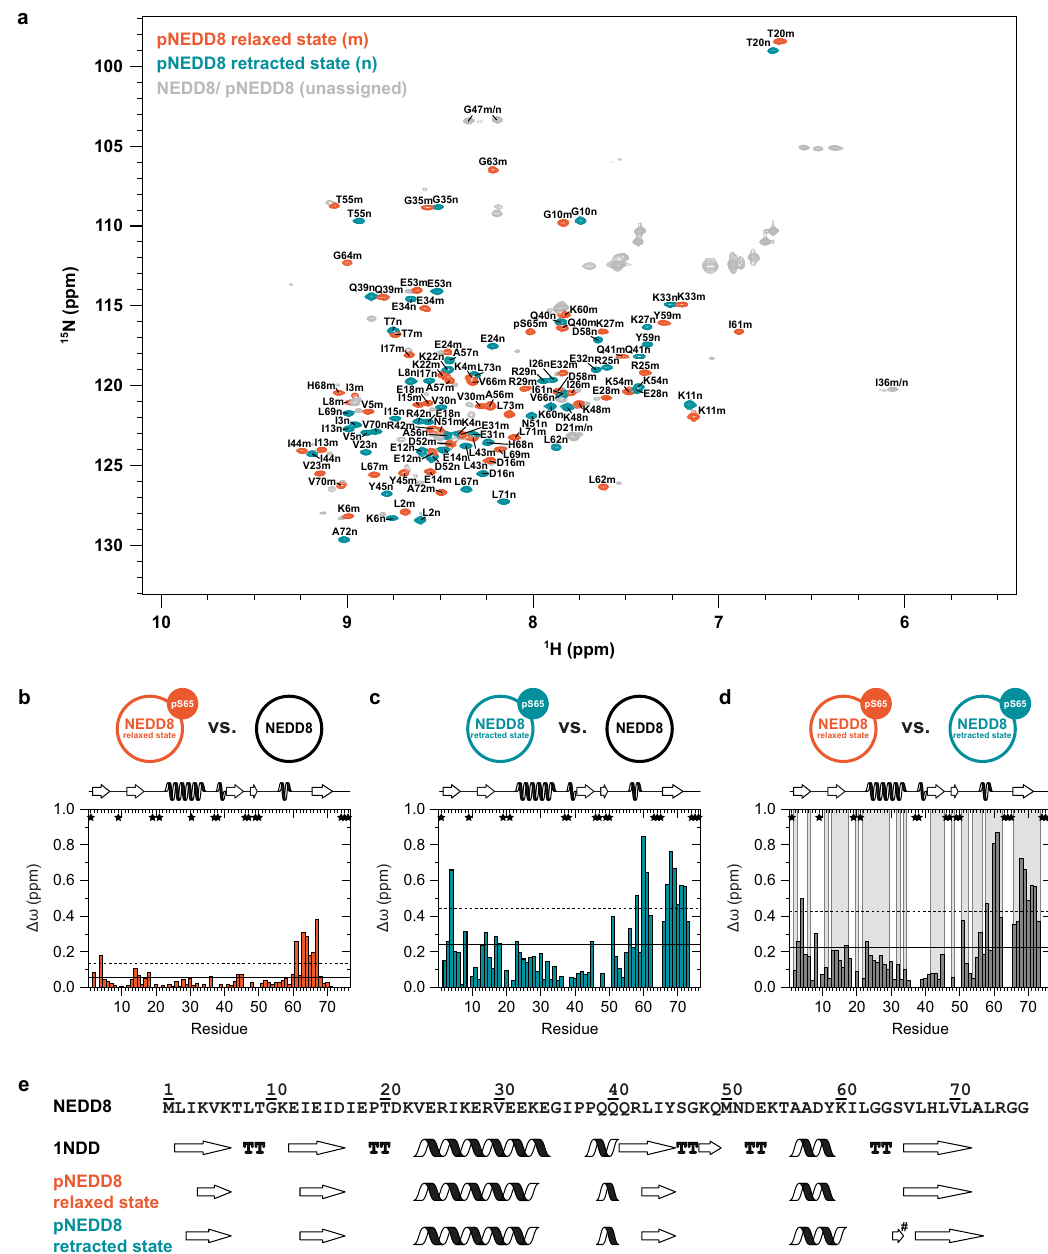
Fig. 2 pNEDD8 adopts two conformations. a Two-dimensional heteronuclear 1 H – 15 N HSQC spectrum of pNEDD8 showing the relaxed state (m) colored in orange and the retracted state (n) colored in green with labeling of assigned resonance signals by using the one-letter code for amino acids. Unassigned resonance signals comprising both NEDD8 and pNEDD8 are colored in grey (cf. Supplementary Fig. 3 for details). b – d Weighted chemical shift perturbation (CSP, Δω ) mapping of pNEDD8 relaxed state vs. NEDD8 ( b ), pNEDD8 retracted state vs. NEDD8 ( c ), and pNEDD8 relaxed state vs. pNEDD8 retracted state ( d ). Δω values exceeding the horizontal straight line are larger than the mean and Δω values exceeding the horizontal dashed line are larger than the mean plus one standard deviation. Residues lacking a CSP value are indicated by an asterisk and residues revealing exchange cross-peaks in the ZZ exchange experiment (cf. Supplementary Fig. 4) are highlighted by a background bar colored in grey. Secondary structure elements according to the NEDD8 crystal structure (PDB ID 1NDD) 73 are depicted on top of the graphs. e Secondary structure predictions as calculated with TALOS-N are illustrated for the relaxed state and retracted state of pNEDD8. In addition, the amino acid sequence of NEDD8 and information regarding secondary structure elements on basis of the crystal structure are shown. The hashtag is highlighting secondary structure predictions that due to lack of chemical shifts, are only